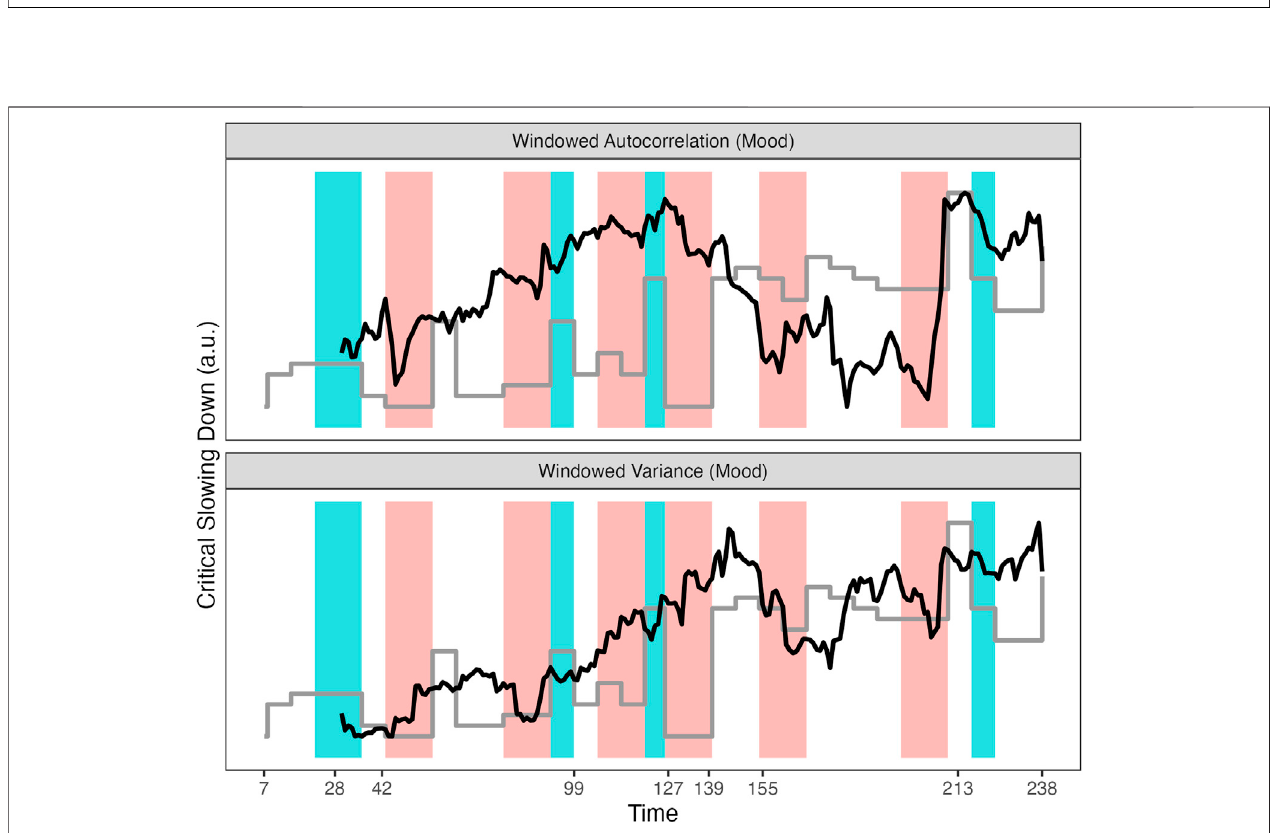
FIGURE 11 | Variance and Autocorrelation of the variables in the Mood subsystem calculated in a sliding window of 30 days. The grey line represents the depression symptom scale SCL-R-90. See text for details.